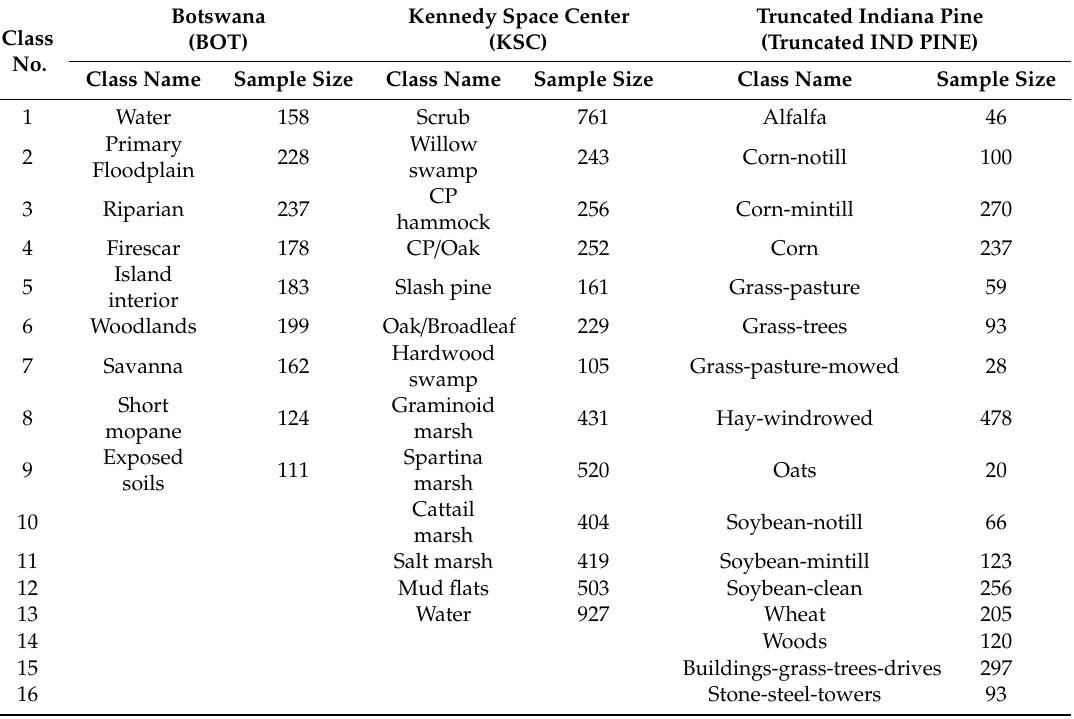
Table 1. Sample size (number of pixels) of each class in datasets from Group I.